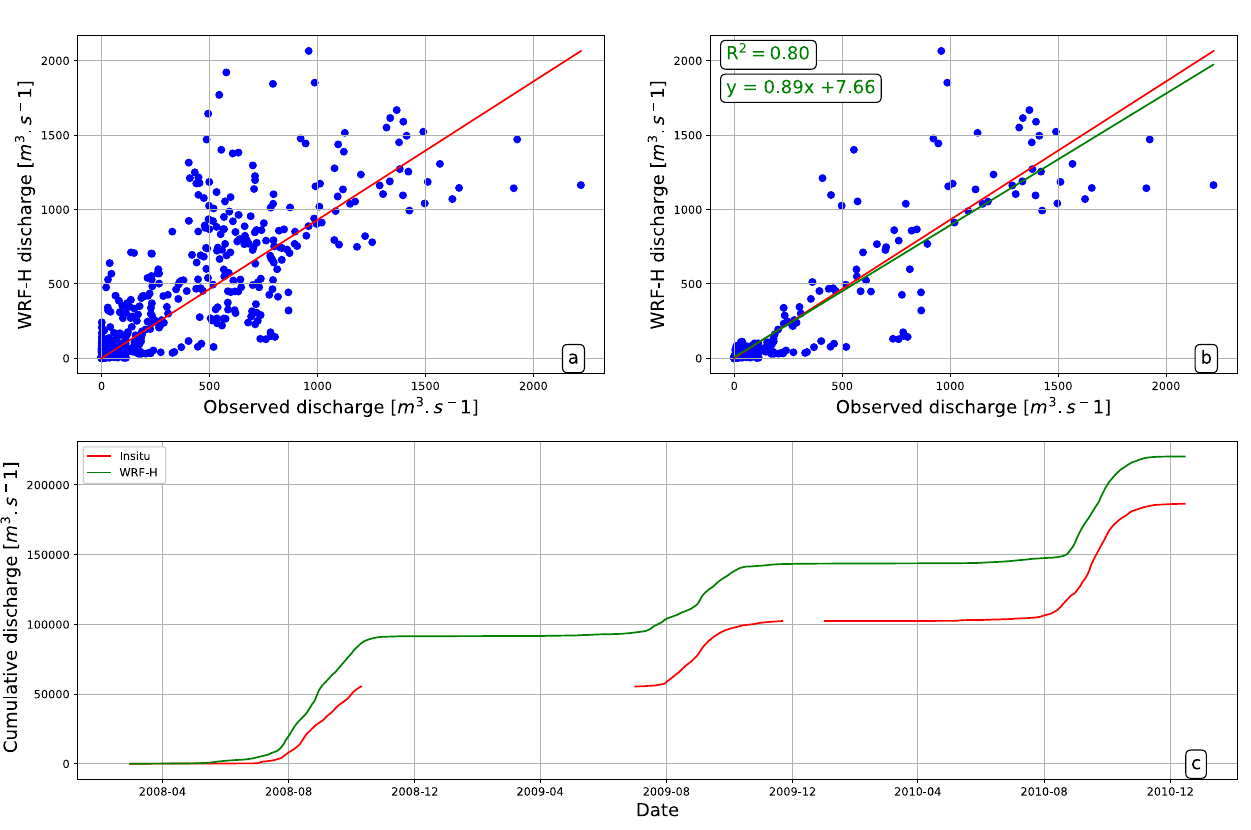
Figure 10. Scatter plot showing comparison of simulated and observed discharges ( a ) for the period 2008–2010, and ( b ) for the flooding year 2010, and ( c ) the cumulative of simulated and observed discharge at Bétérou.